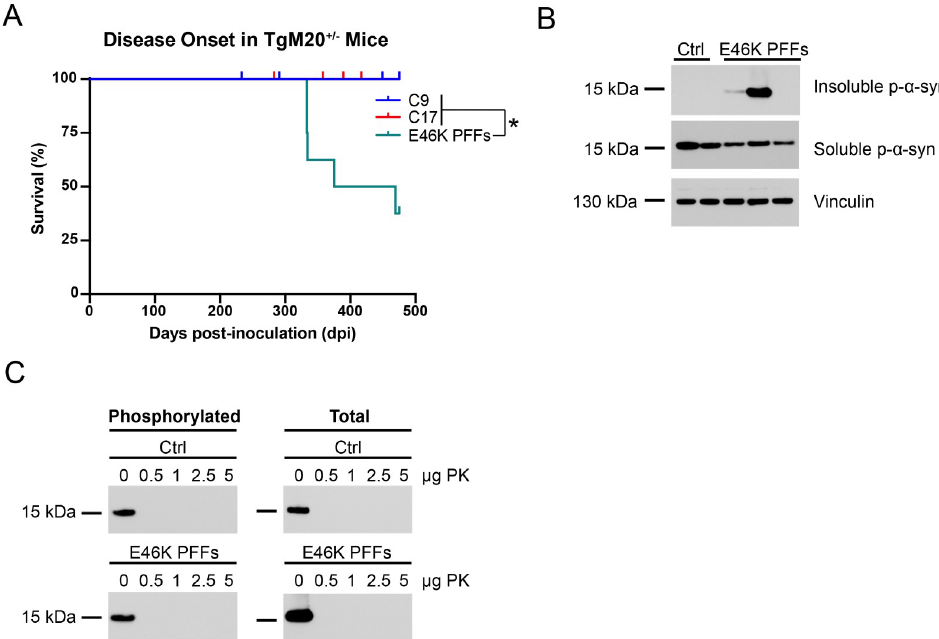
Fig 5. TgM20 +/- mice propagate E46K α -synuclein PFFs. Eight-week-old TgM20 +/- mice were inoculated with 30 μ g of E46K human α -synuclein PFFs or 30 μ L of 1% brain homogenate from control patient samples. (A) Kaplan-Meier plot shows five of eight mice inoculated with E46K PFFs developed neurological disease by 475 days postinoculation (dpi; P > 0.05). Incubation times for control-inoculated mice previously reported in Holec, et al ., 2022 [46]. (B) Two brain homogenates from TgM20 +/- mice inoculated with control patient samples and three homogenates from mice inoculated with E46K PFFs were assayed for the presence of insoluble α -synuclein following detergent extraction (EP1536Y primary antibody). Some of the samples from E46K PFF–inoculated TgM20 +/- mice contained aggregated α - synuclein (EP1536Y primary antibody), though soluble α -synuclein was present in all mice tested. Vinculin shown as a loading control. (C) Proteinase K (PK) digestion was performed using brain homogenates from control-inoculated and E46K PFF–inoculated TgM20 +/- mice using 0, 0.5, 1, 2.5, and 5 μ g PK. After detergent extraction, phosphorylated and total α -synuclein in the resulting protein pellets were detected via Western blot using both EP1536Y (left) and MJFR1 (right) primary antibodies, respectively.